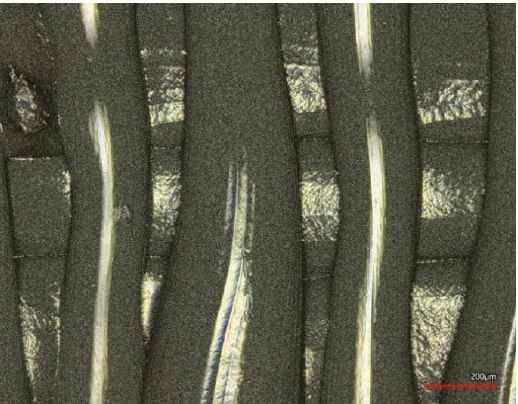
Figure 10. Confocal Laser Scanning Microscope (CLSM) image of PLA object, sample—1. Scale bar indicates 200 μ m.